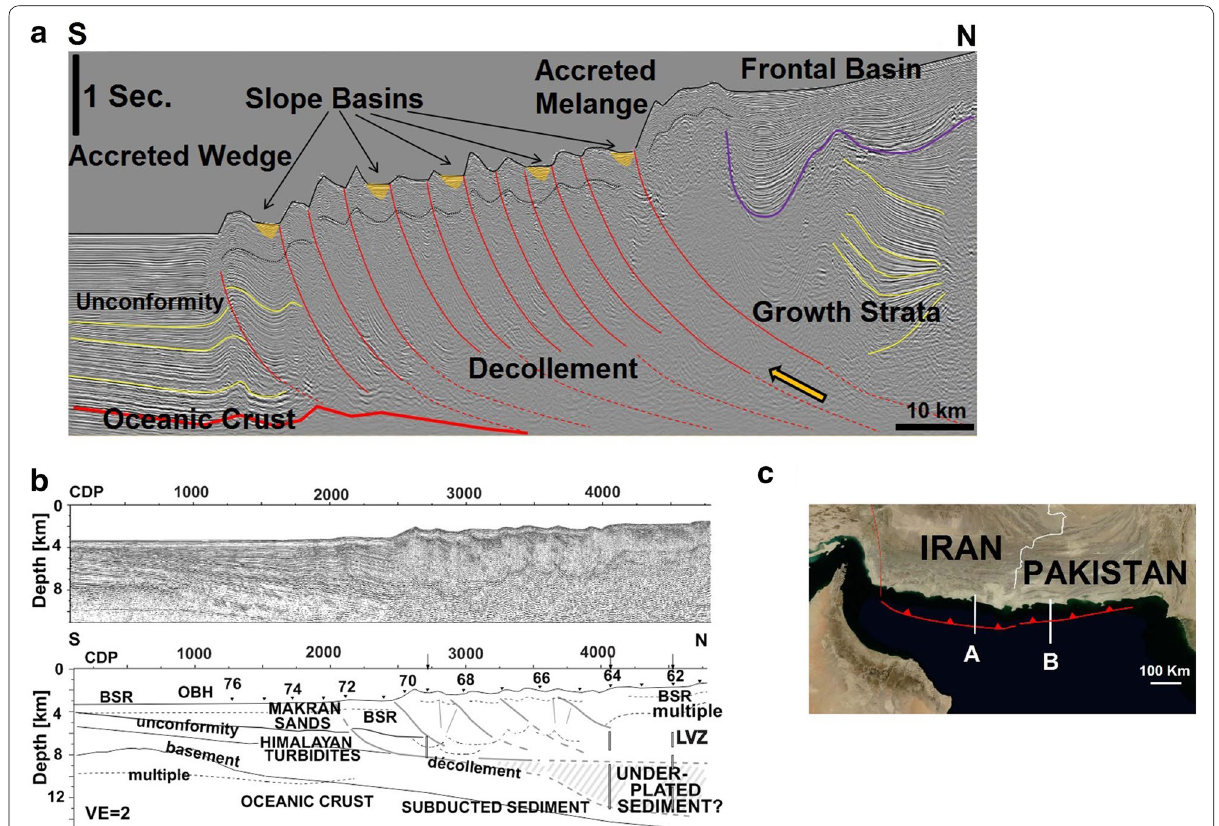
Fig. 7 a The offshore seismic reflection profile on the Iranian side of the Makran and the interpretation is superimposed as the line drawing on the seismic section. The yellow arrow indicates the displacement direction [modified after Mokhtari et al. (2008)]. b The offshore seismic reflection profile in the Pakistani side of the Makran and its interpretation as the line drawing below [from Kopp et al. (2000)]. c The location of both seismic profiles shown on the index map